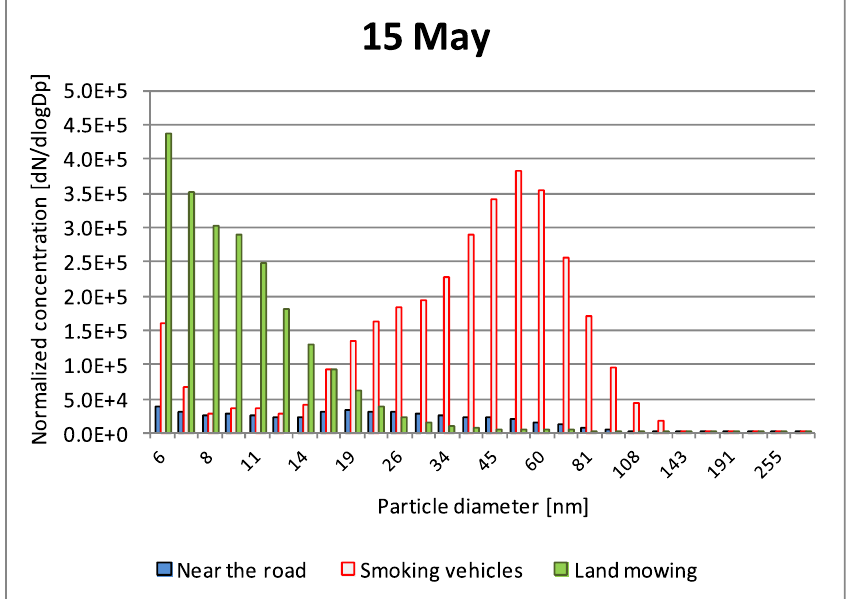
Figure 13. Particle number distribution measured in Libeznice on 15 May according to source of particles (road traffic excluding high emitters, smoking vehicles, lawn